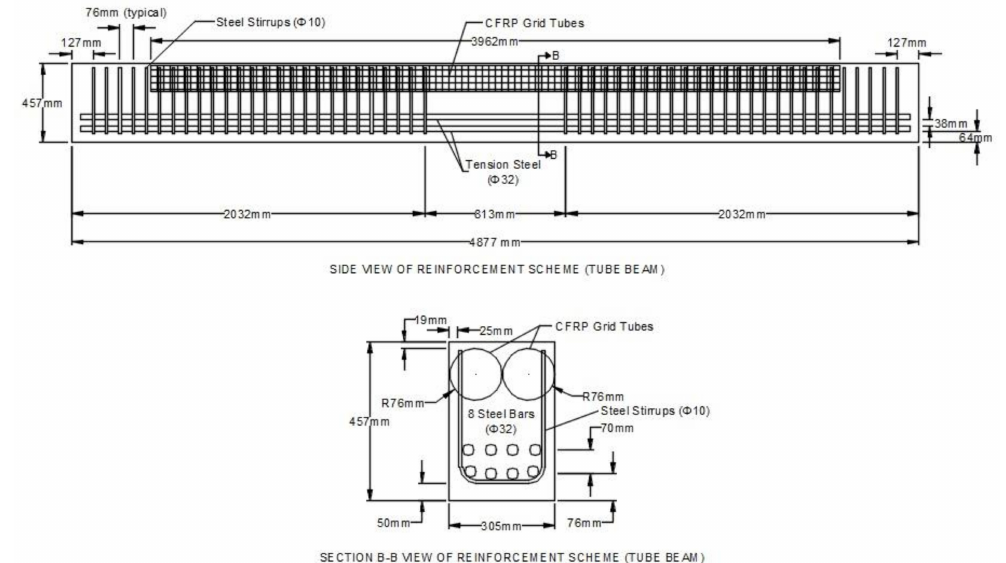
Figure 10. Side (top part of figure) and cross-sectional (bottom part of figure) views of reinforcement scheme for tube beam showing longitudinal tension steel ( Φ 32 bars), steel vertical U-shaped stirrups ( Φ 10 bars), and 2 CFRP grid tubes (coils) at the top of the beam used to confine concrete in the compression